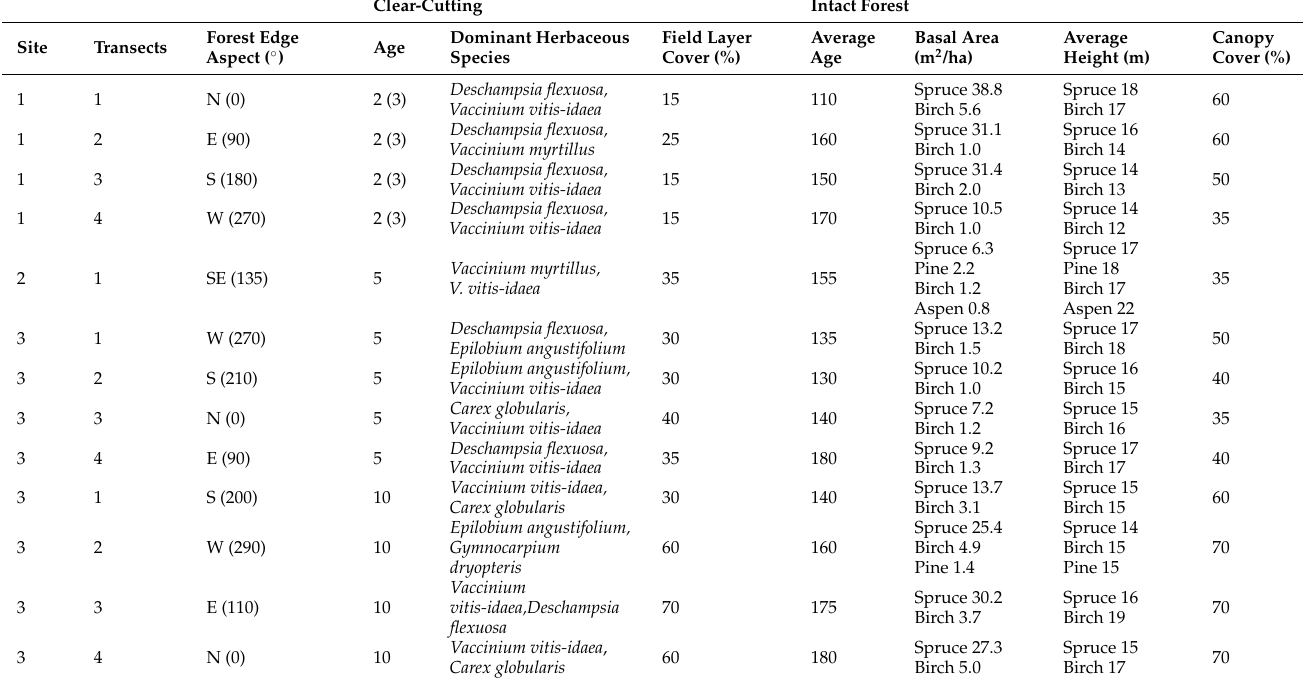
Table 1. Characteristics of the spruce stands and